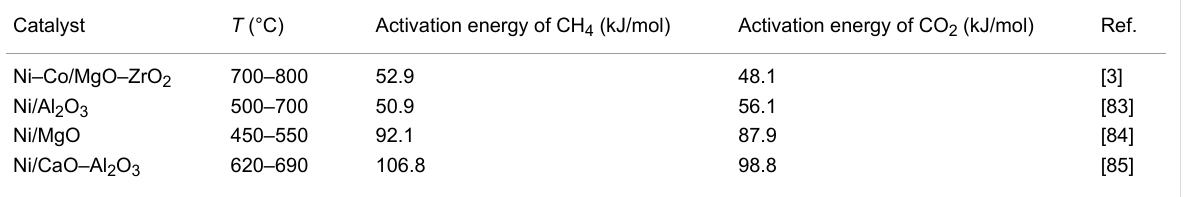
Table 1: Activation energies of various catalysts for DRM [3].